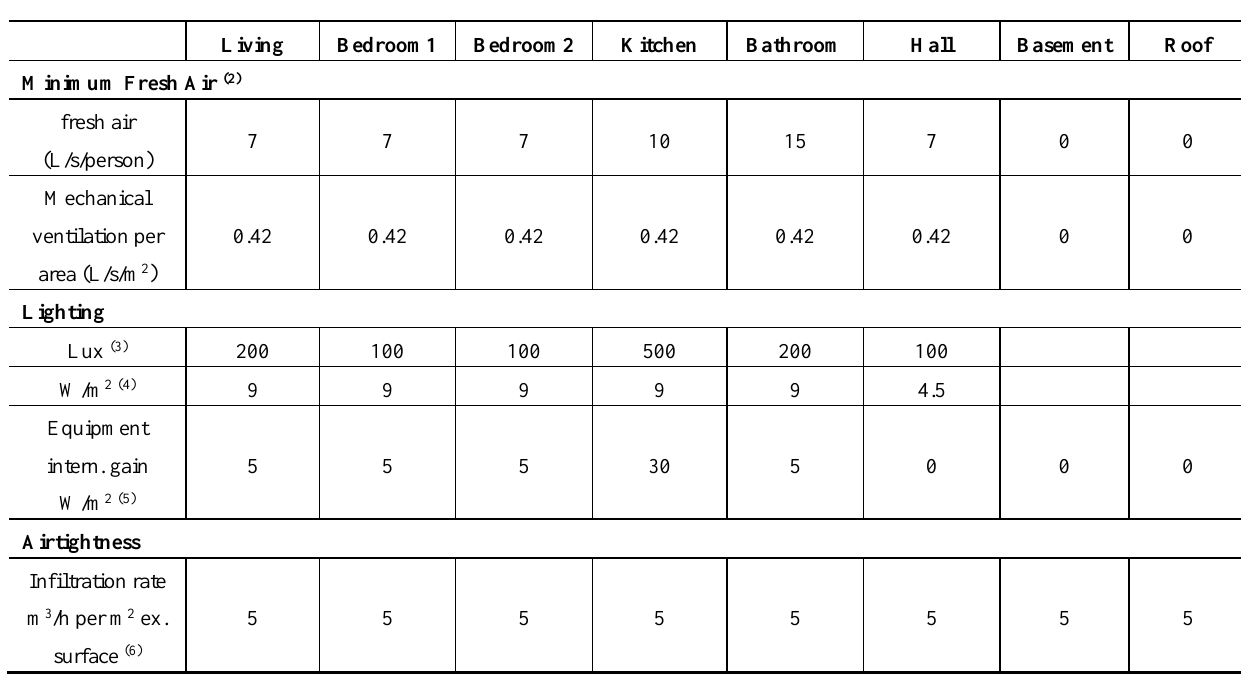
Table 6.2; (6) [39] Table